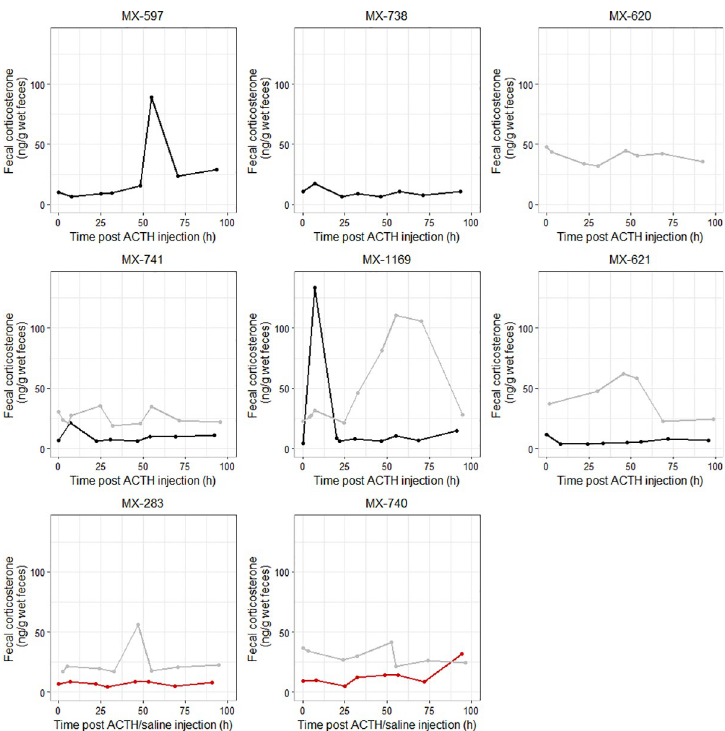
Fig 1. Individual fecal corticosterone levels of the muskoxen as a function of the time following a single injection of ACTH during the winter (ACTH dose 1 IU/kg–n = 6) and/or of ACTH or saline (control) during the summer (ACTH dose 2 IU/kg–n = 5 ACTH-injected and n = 2 controls). Winter data are indicated as grey lines. Data for the ACTH-injected and control animals during the summer challenge correspond to the black and red lines, respectively. https://doi.org/10.1371/journal.pone.0249281.g001 During the summer challenge, for MX-741 and MX-1169, fecal corticosterone concentra- tions increased by 228 and 2,814%, respectively, at approximately 7 h post-ACTH injection before decreasing back to levels similar to those measured at time 0 by 22 h. MX-597 exhibited a 776% increase in fecal corticosterone at 55 h. The other two ACTH-injected animals (MX- 738 and MX-621) had maximal percentage increases lower than 70% (Fig 1 and Table 2). The